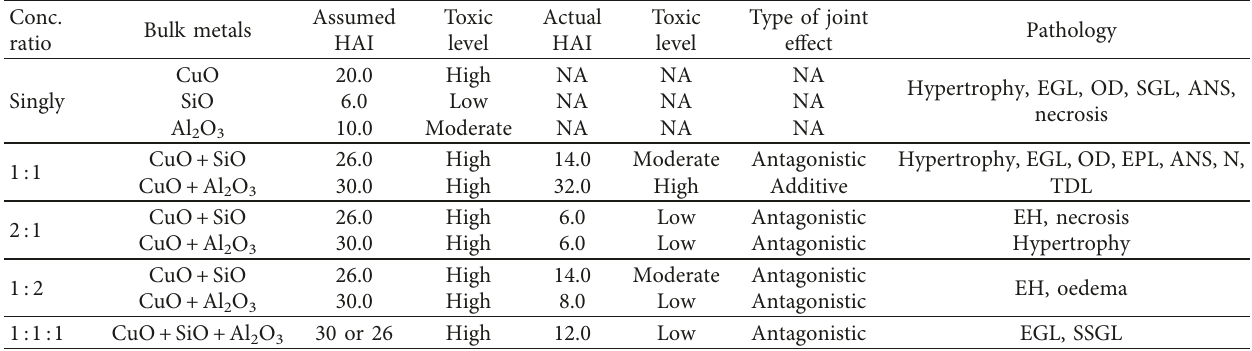
Table 3: A 28-day single and joint exposure of Clarias gariepinus to bulk size metals. Conc.